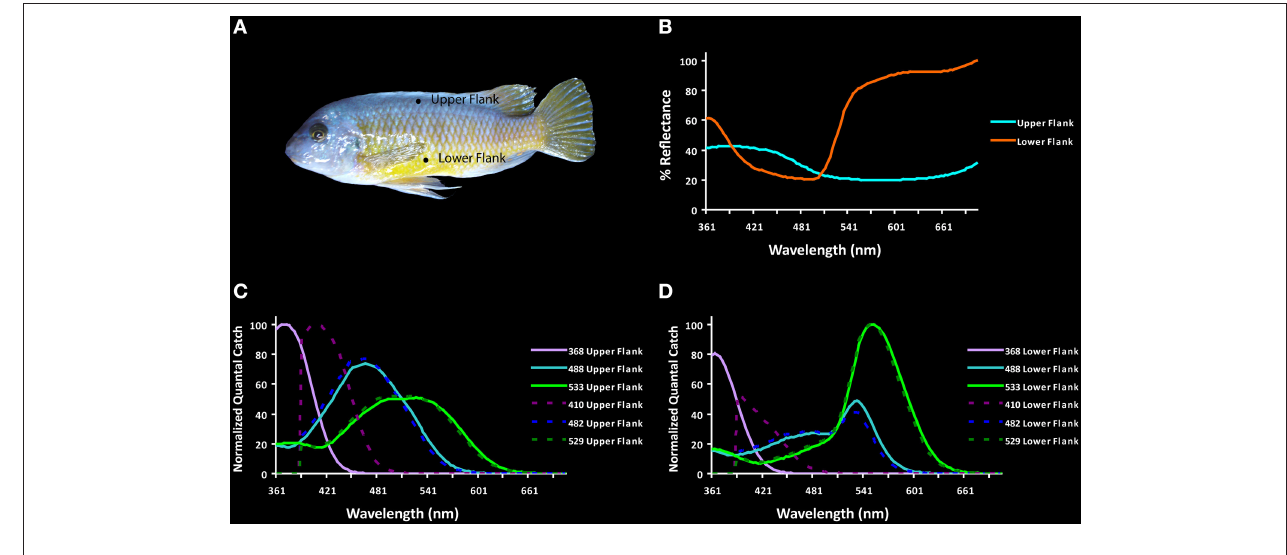
FIGURE 10 | Labeotropheus c.f. fuelleborni “Katale.”